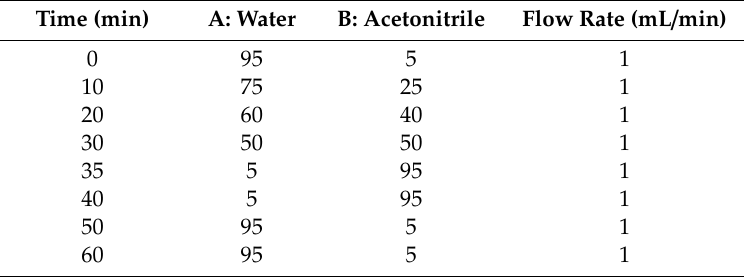
Table 1. HPLC gradient